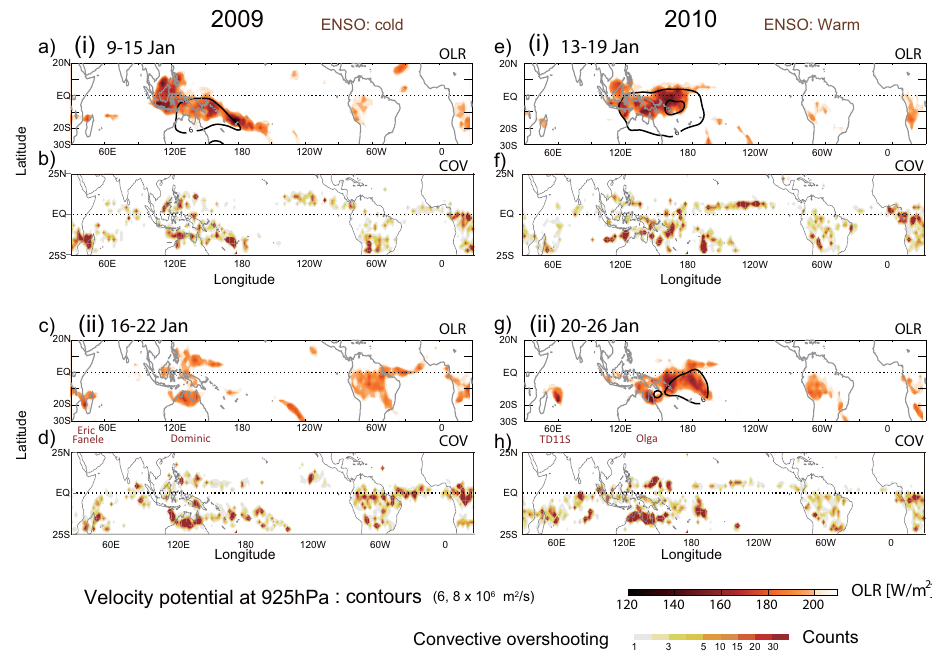
Figure 4. (a, c, e, g) Seven-day mean OLR (color shadings) with velocity potential at 925hPa (contours of 6, and 8 × 10 6 m 2 s − 1 ). (b, d, f, h) Seven-day average of the number of COV in each 2.5 ◦ lat–lon grid box. Panels (a, b) and (c, d) are 7-day periods before (i) and after (ii) the onset of the event in January 2009. Panels (e, f) and (g, h) are the same as panels (a, b) and (c, d) except for the event in January 2010.